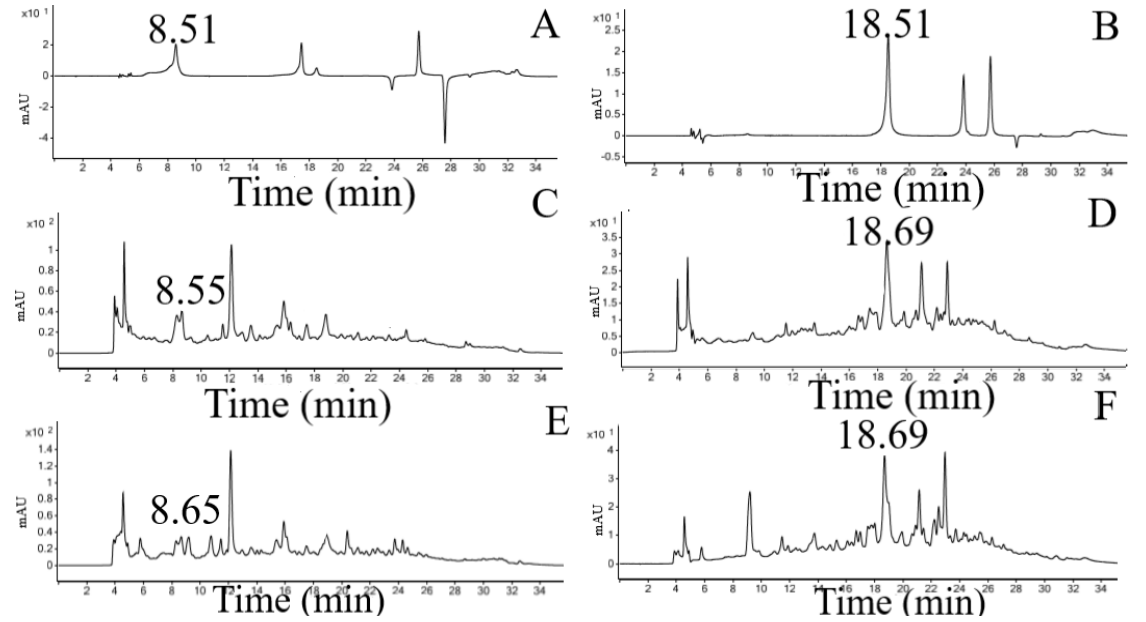
Figure 1. Chromatograms obtained for standards, crude extract and microparticle. ( A ) Gallic acid standard (280 nm) and ( B ) caffeic acid standard (325 nm). ( C ) Peak gallic acid in crude extract (280 nm). ( D ) Peak caffeic acid in crude extract (325 nm). ( E ) Peak gallic acid in microparticle (280 nm). ( F ) Peak caffeic acid in microparticle (325 nm).